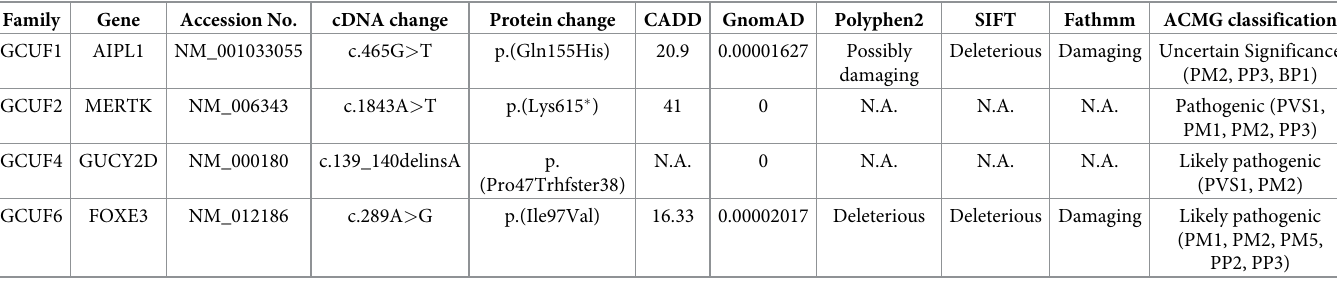
Table 2. Genes, identified novel variants and their ACMG